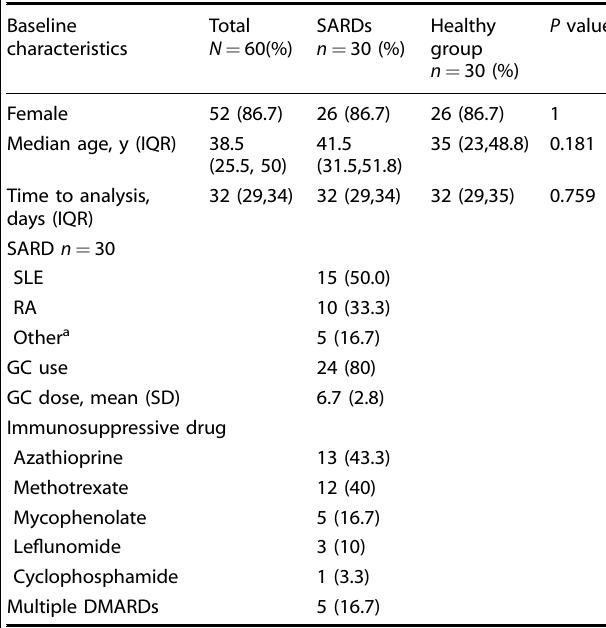
SARDs systemic autoimmune rheumatic diseases, DMARDs disease- modifying antirheumatic drugs, GC glucocorticoids, RA rheumatoid arthritis, SLE systemic lupus erythematosus. a n = 2 psoriatic arthritis, n = 1 systemic vasculitis, n = 1 systemic sclerosis, n = 1 dermatomyositis.